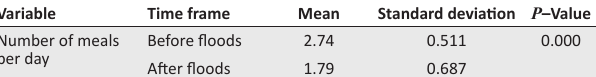
TABLE 2: The impact of the Babessi floods on Livestock assets.